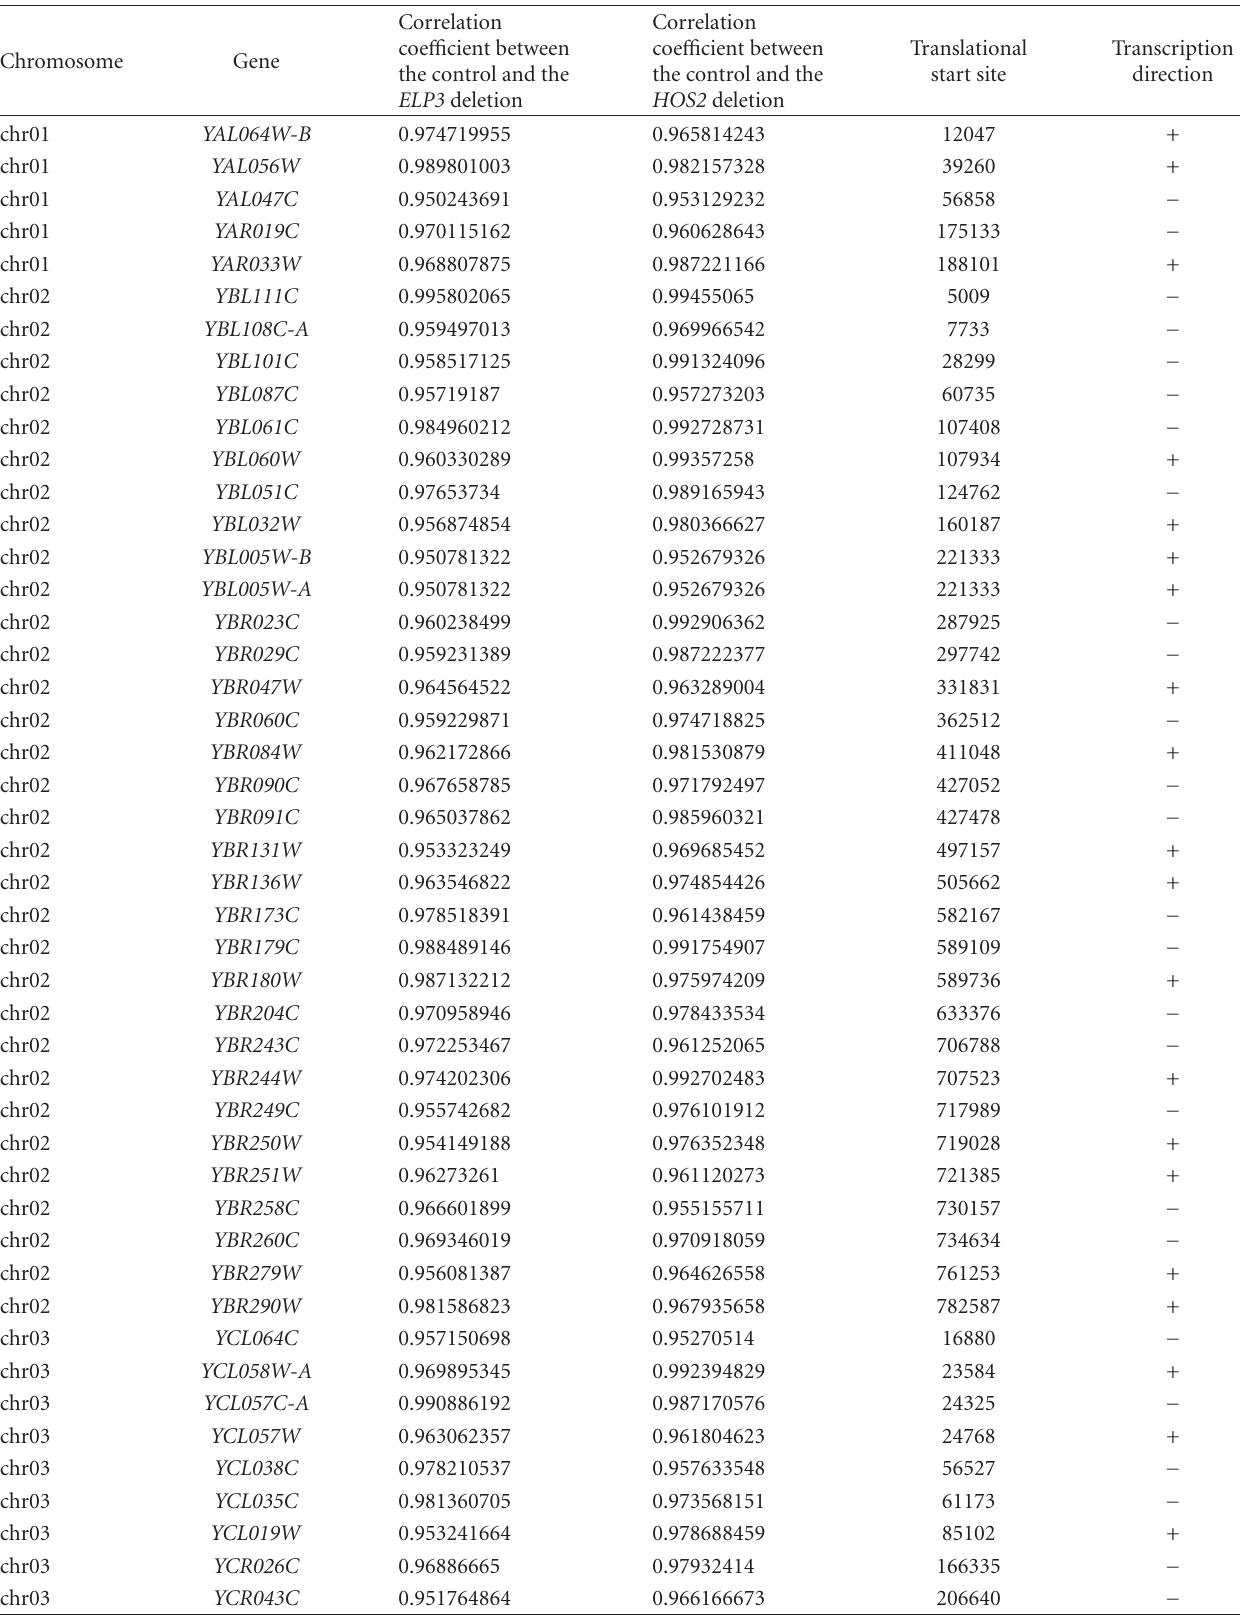
Table 3: Genes of Saccharomyces cerevisiae with highly conserved nucleosome positions in the promoters of the control and histone modification gene deletion